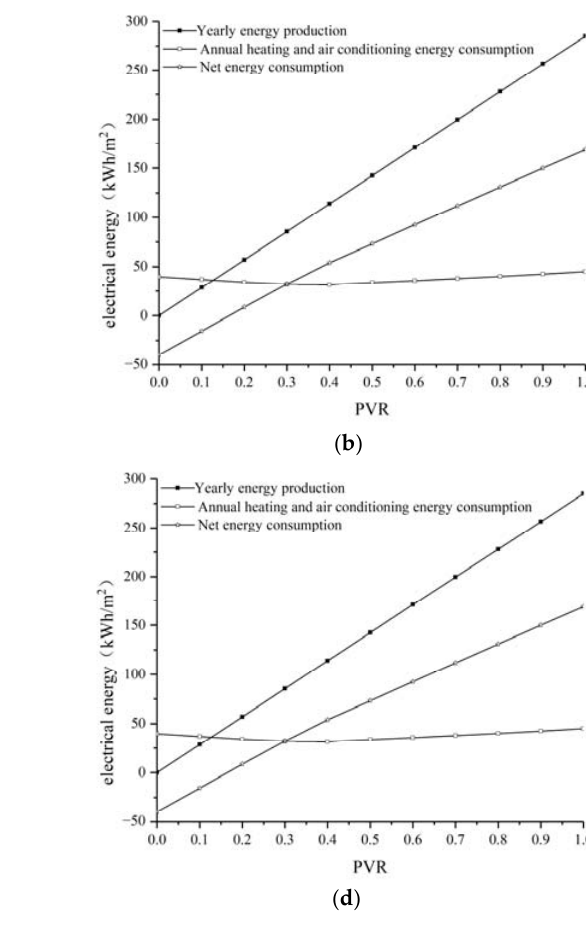
Figure 7. Impact analysis of PVR in different regions: ( a ) Guangzhou; ( b ) Nanjing; ( c ) Beijing; ( d ) Harbin.